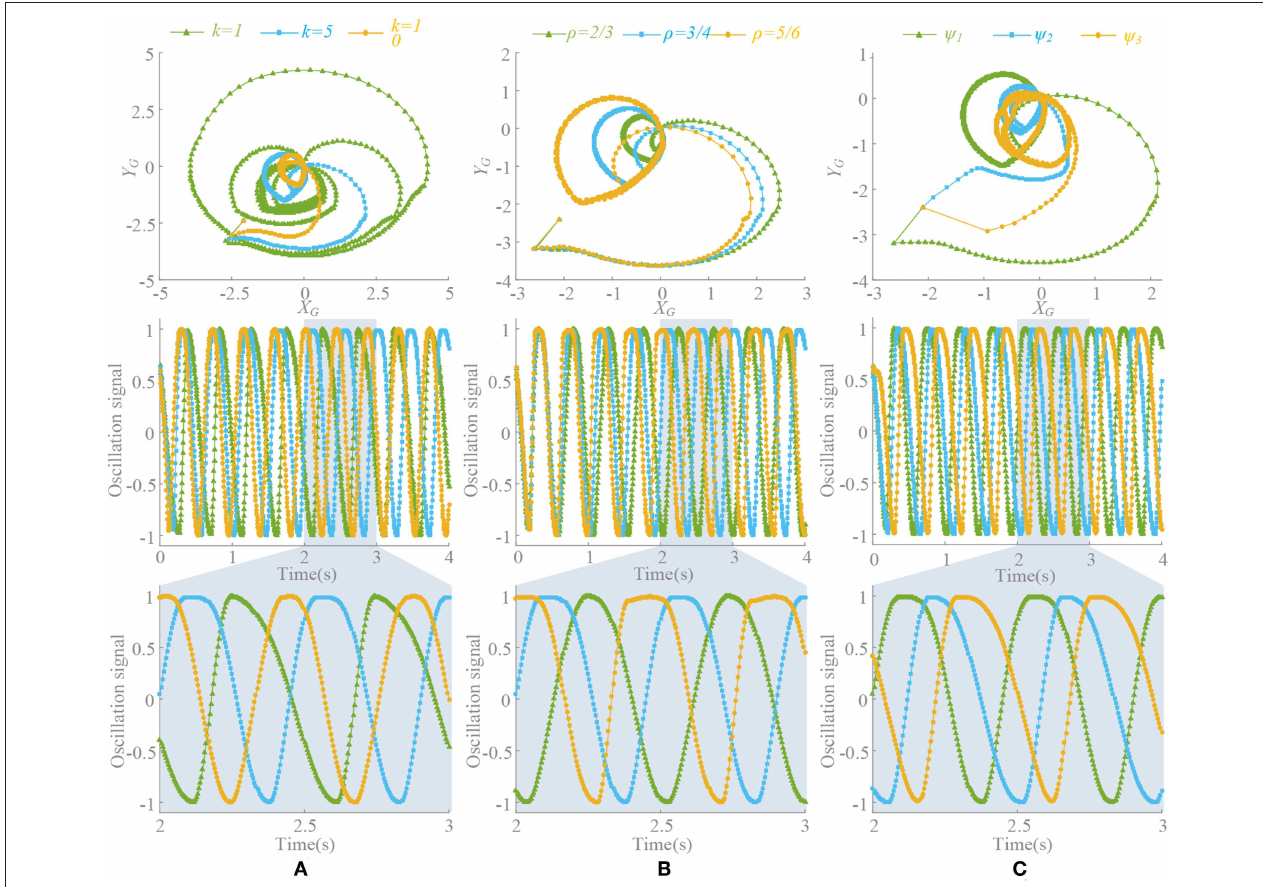
FIGURE 4 | Influence of different parameters with ρ 6= 0.5. Signal of limb 1 is selected. (A) Different value of k (t), phase factors ψ i = Φ i /2 π , ψ = [0, 0.5, 0.5, 0, 0, 0.5], ρ = 3/4 and initial point (0.7, 0.8). Different k (t) leads a different limit circle scale of G {¯ υ 0 } and the deformation is directly related to k ( t ) G {¯ υ 0 } . (B) Different ρ = [2/3, 3/4, 5/6], initial point (0.7, 0.8), and k (t) = 5. Large ρ leads to large deformation. (C) Different phase factors ψ 1 = [0, 0.5, 0.5, 0, 0, 0.5], ψ 2 = [0, 0.5, 0, 0.5, 0, 0.5], ψ 3 = [0.2, 0.4, 0.6, 0.1, 0.9, 0.7], k (t) = 5, initial point (0.7, 0.8), and ρ = 3/4. Different motion pattern has different limit circle of G {¯ υ 0 }